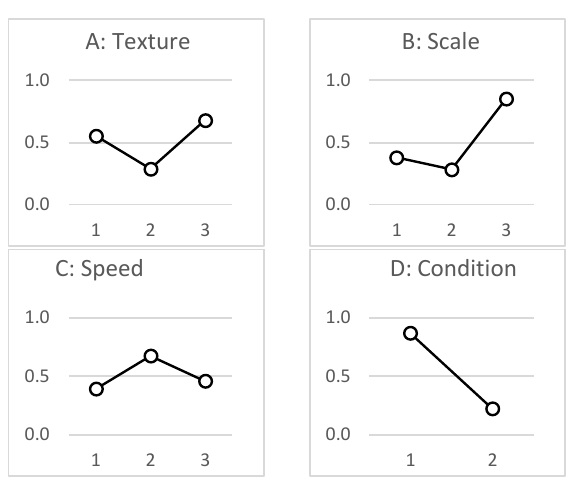
Figure 4. Factor level influence on 